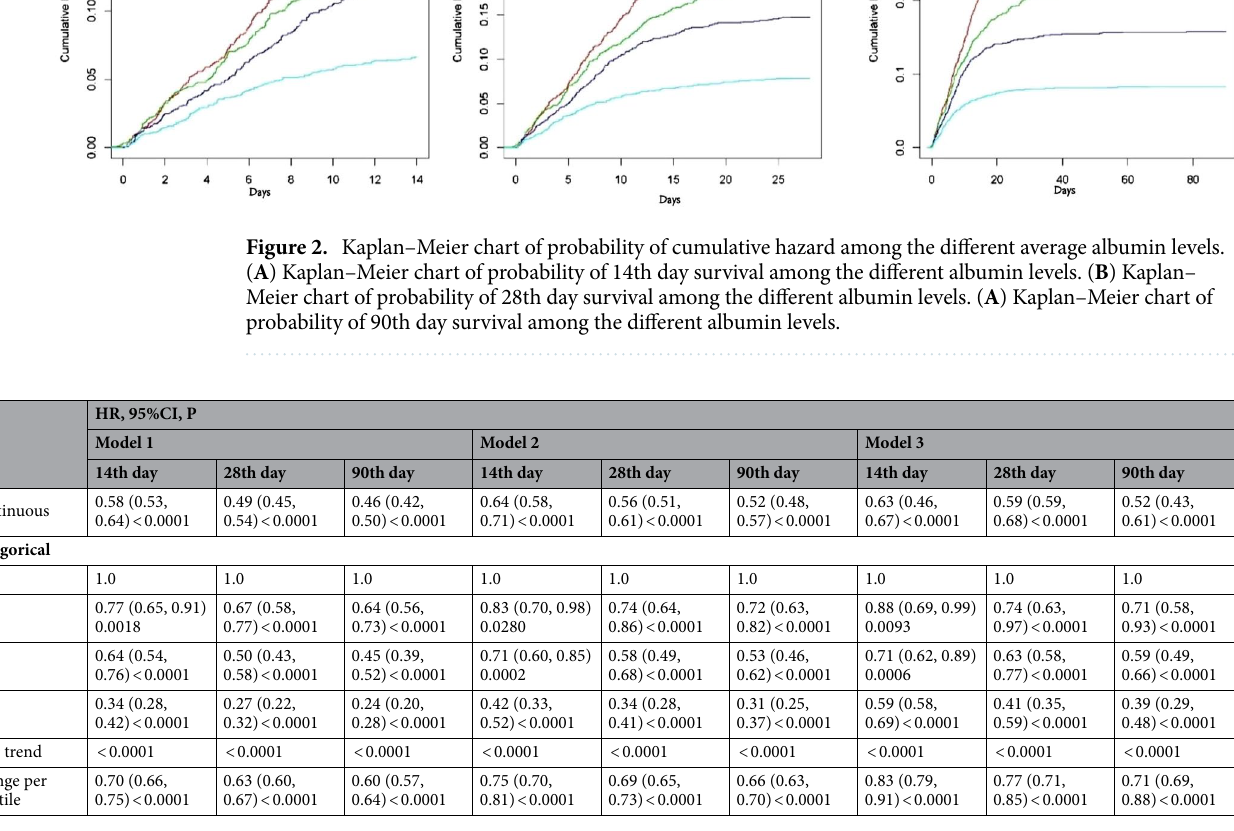
Table 2. Average albumin and the risk of all-cause mortality by Cox proportional hazards. Model 1: adjust for none. Model 2: adjust for gender; coronary; age; hypertension; diabetes; ARDS; COPD; renal failure. Model3: adjust for heart rate; SBP; mean arterial pressure; diastolic pressure; respire rate; temperature; SPO2; platelet; potassium; sodium; creatinine; hemoglobin; WBC; AST, BNP, LVEF, diuretic, ACEI/ARB/ARNI, cardiac